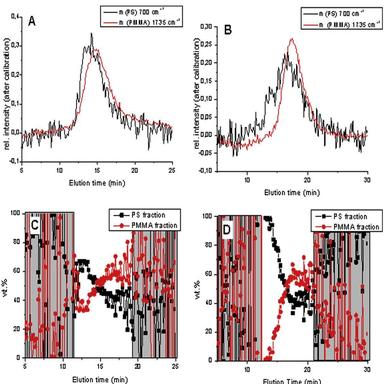
(A) and (B) ThFFF-FTIR fractograms of copolymer samples SMA1 (A) and SMA2 (B). Relative concentrations of styrene and MMA units as a function of elution time, SMA1 (C) and SMA2 (D). Experimental ThFFF conditions as in 2.